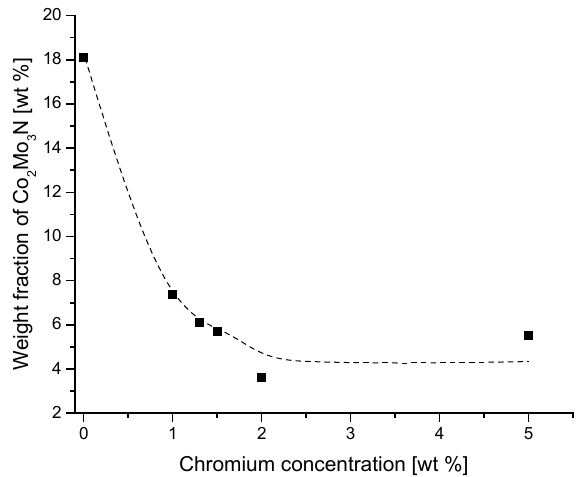
Figure 2: The weight fraction of Co data as a function of chromium concentration in the sample. A dashed line is for an eye-guidance only.